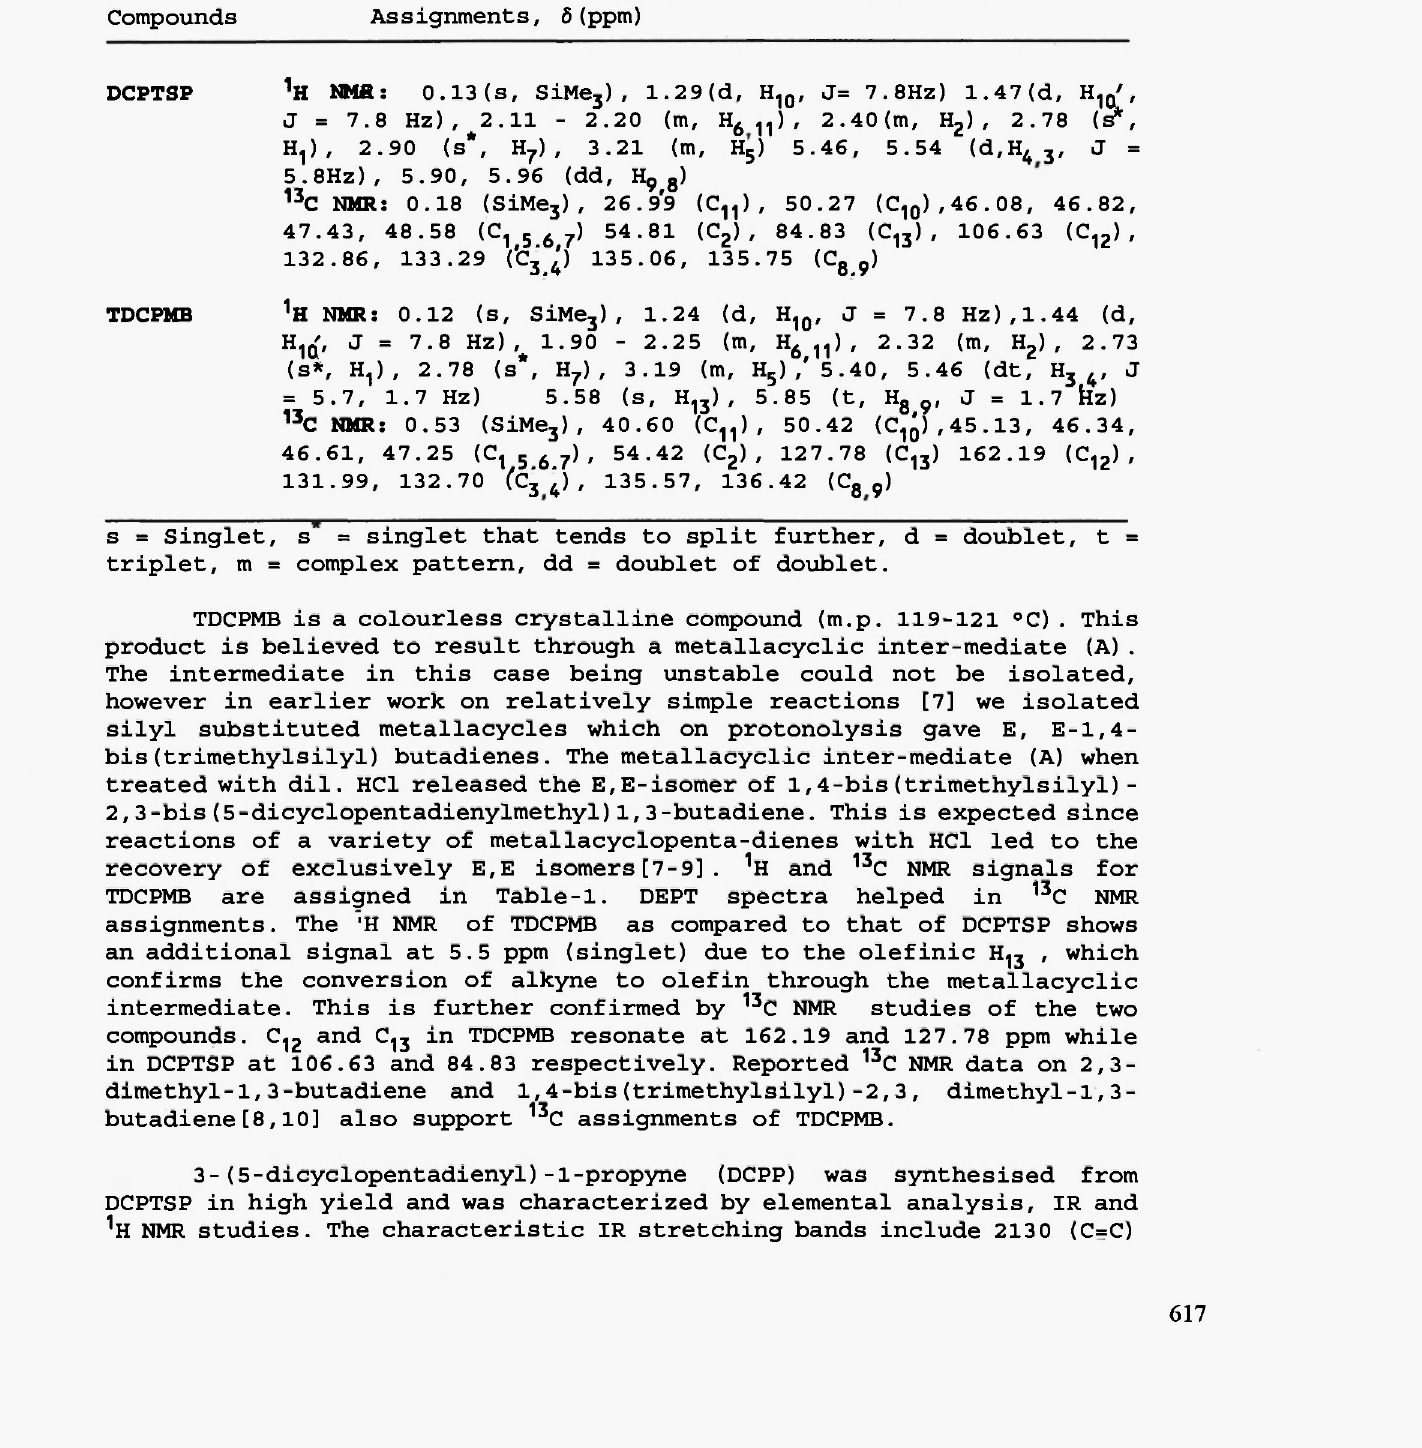
Table -1: 1 H and 13 C NMR spectral data of DCPTSP and TDCPMB Compounds Assignments,